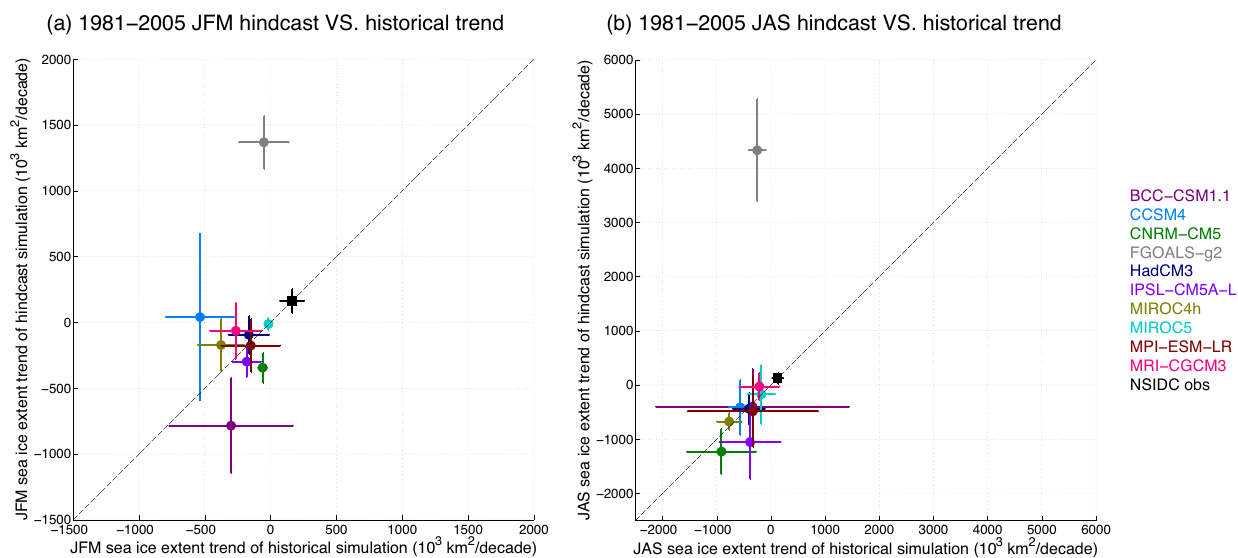
Fig. 5. Hindcast vs. historical Southern Ocean sea ice extent trend for summer (a) and winter (b) , computed over the period 1981–2005. The different colours refer to the different models. For each model the dot refers to the ensemble mean of the trends and the horizontal (vertical) bar shows the ensemble mean of the standard deviations of the trends in the historical (hindcast) simulations. Black square is for the trend of the observations (Cavalieri and Parkinson, 2008). The vertical and the horizontal black bars are for the standard deviation of the observed trend which are barely distinguishable due to their small values. Dashed line represents the line y(x) = x . The computed standard deviations of the trends takes into account the autocorrelation of the residuals (see for instance Santer et al., 2000; Stroeve et al.,